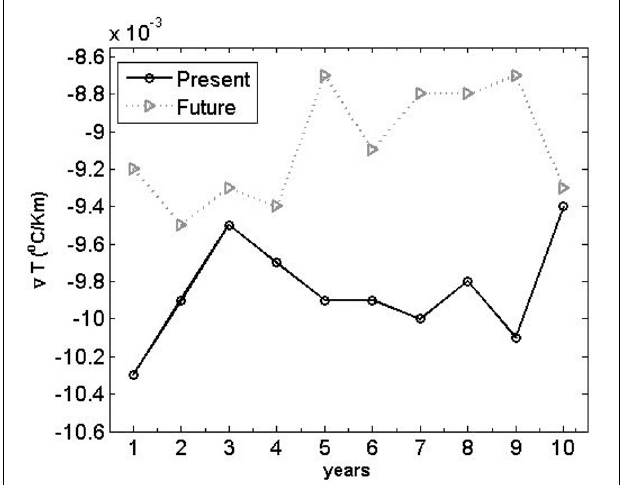
FIGURE 7 | Mean meridional temperature gradient ( ◦ C/1000km) over the domain, for every year of integration. (Soldatenko and Tingwell, 2013). The model experiment for the future climate indicates that during the NH winter the static